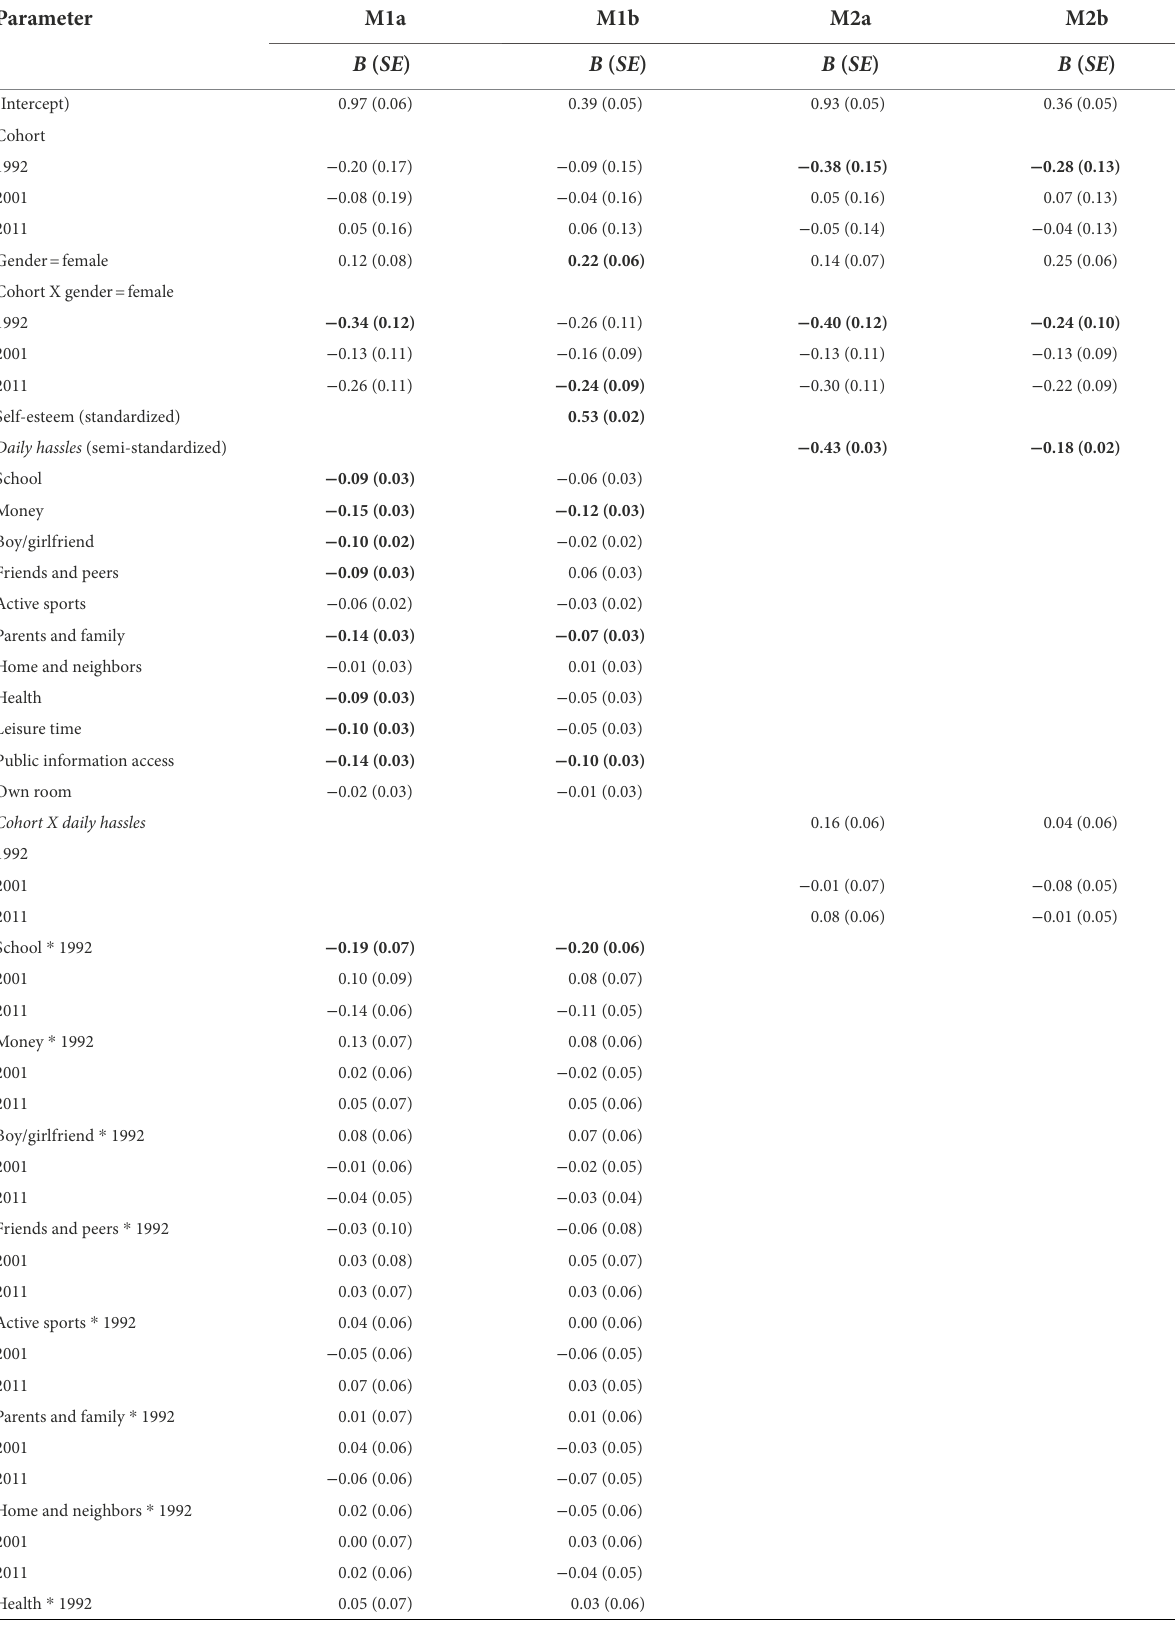
TABLE 3 Parameters of the linear models predicting life